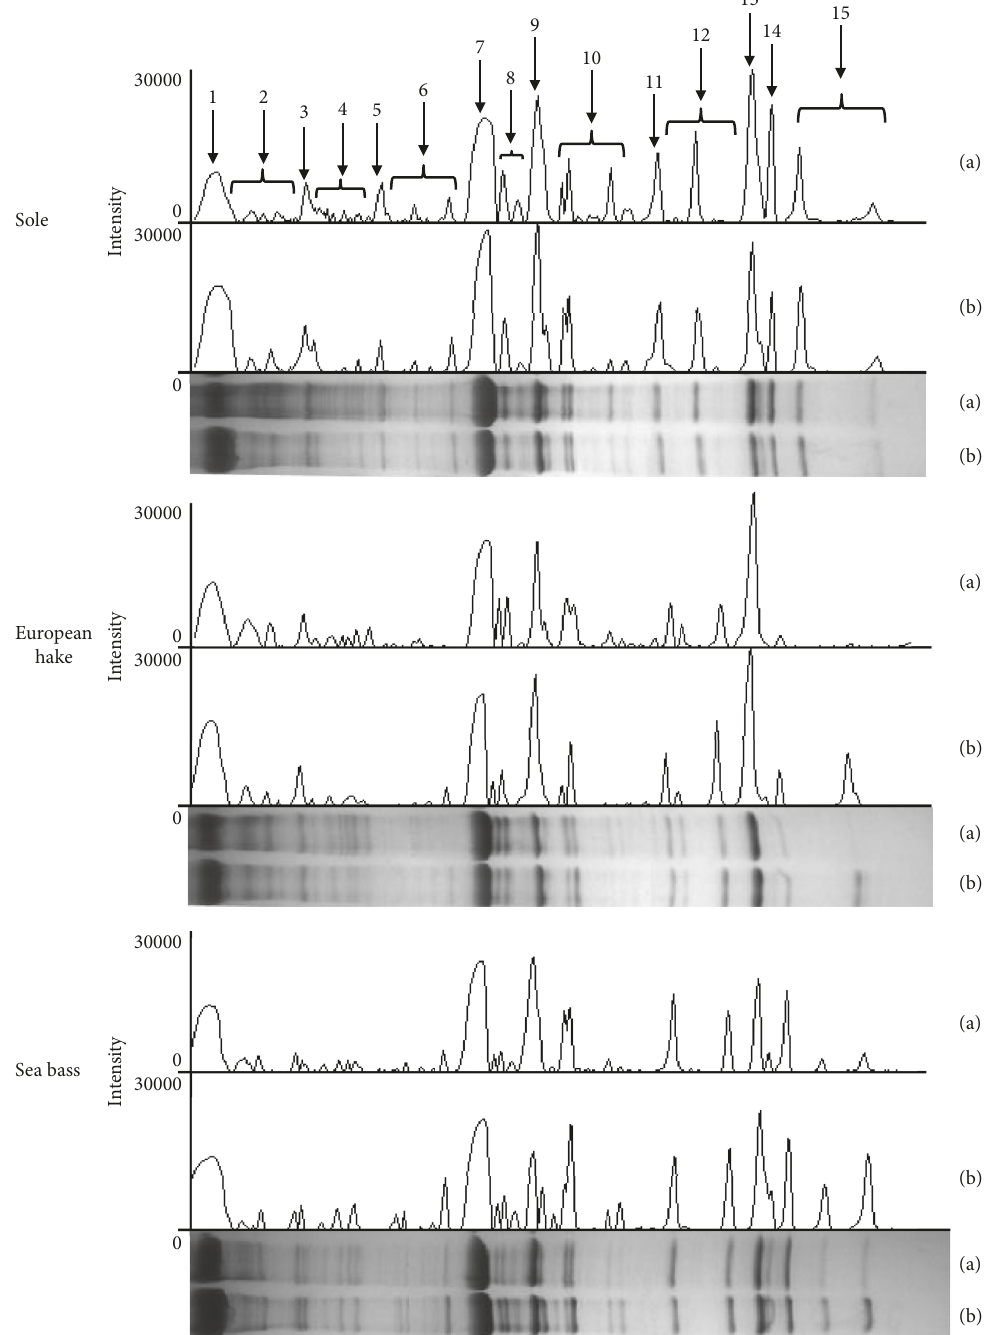
Figure 4: Densitometric profile and SDS-PAGE of a pool of 15 myofibrillar extracts obtained from sole, European hake, and sea bass samples extracted with denaturing (a) and nondenaturing (b) solutions (1 � myosin heavy chain; 2 � 180–110 kDa; 3 � α -actinin; 4 � 95–55kDa; 5 � desmin; 6 � 51–47 kDa; 7 � actin; 8 � 40–38 kDa; 9 � tropomyosin; 10 � 33–23kDa; 11 � myosin light chain 1; 12